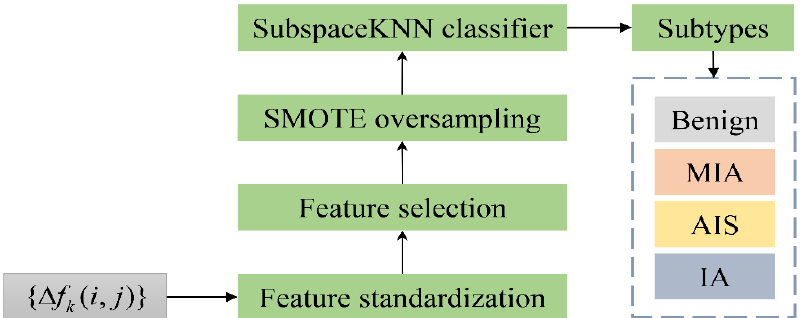
Figure 4. Schematic diagram of the GGN subtype classification based on FFDC.